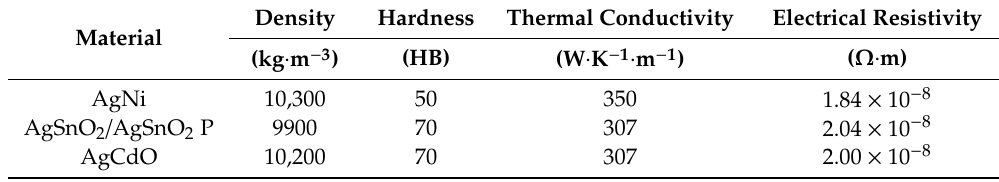
Table 1. Selected properties of the contact materials used in the